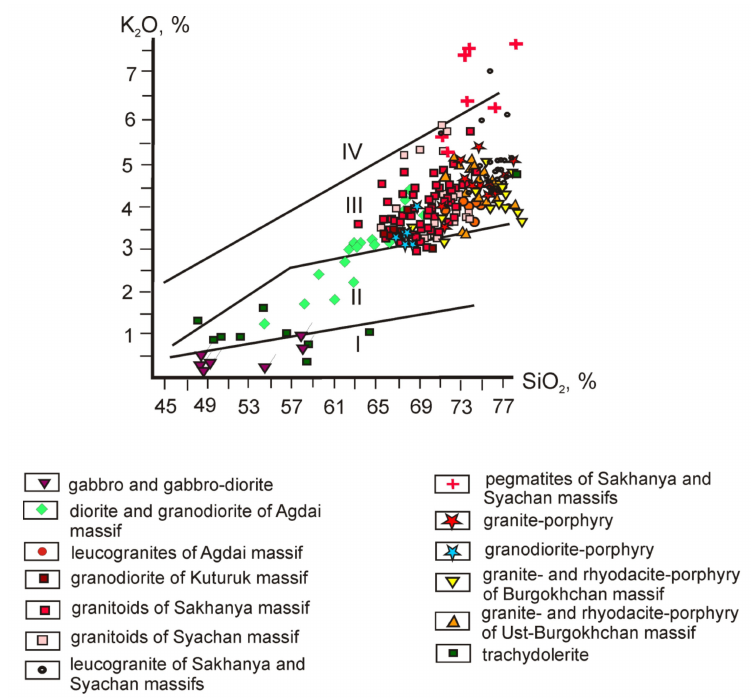
Figure 6. Petrochemical series of magmatic rocks of the Selennyakh River basin. Fields of the diagram [40]: I—low potassic tholeitic, II—medium potassic calc-alkaline, III—high-potassic calc- alkaline, IV—shoshonite.